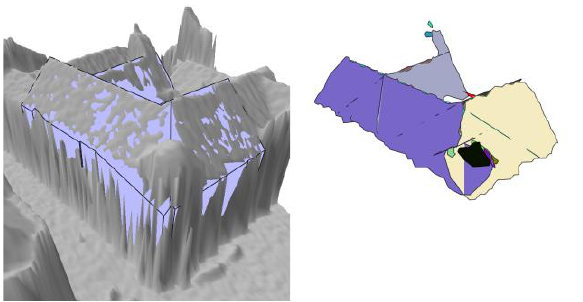
Figure 4. Reconstructed building overlaid by digital surface model (left) and sub-surface segments (right).